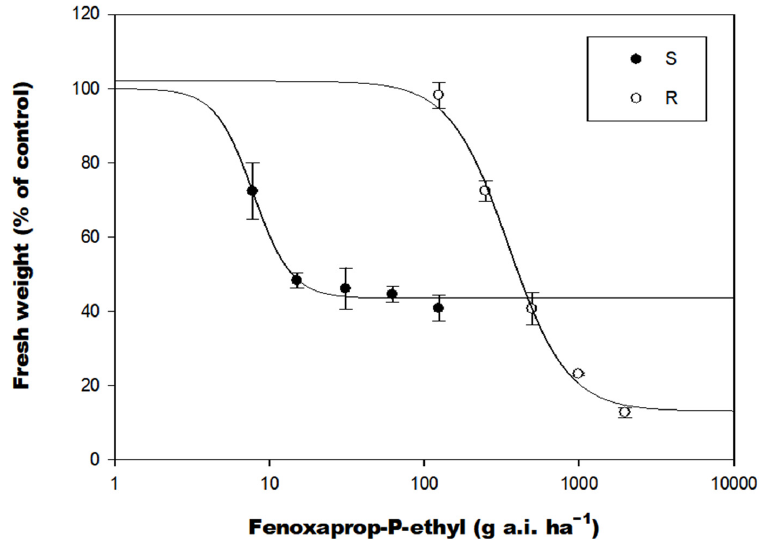
Figure 1. Dose-response of resistant (R) and susceptible (S) Alopecurus japonicus populations to fenoxaprop-P-ethyl. Data points are means ± SE ( n = 3). X line is the fenoxaprop-P-ethyl application dose, Y line is the fresh weight at each fenoxaprop-P-ethyl